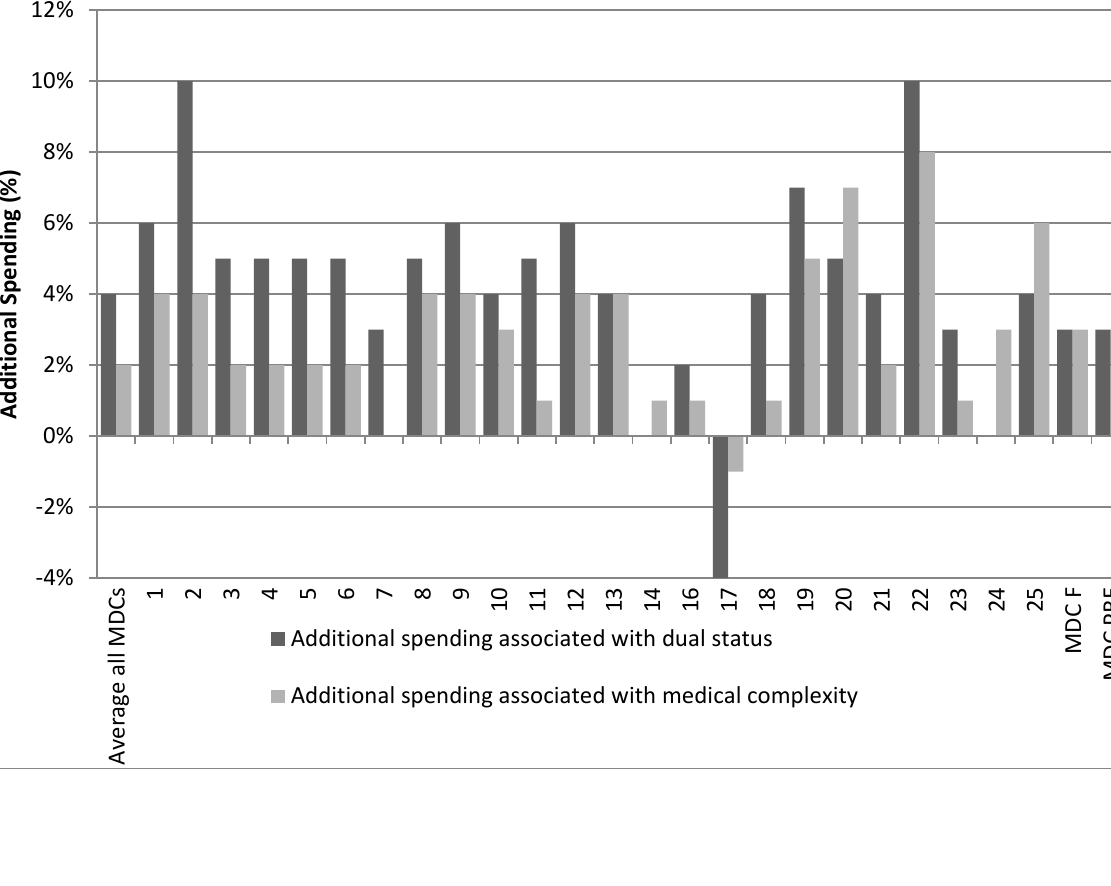
Figure 7.2. Consistency of Relationship Between Dual enrollment status or Medical Complexity and MSPB Spending Across Major Diagnostic Categories